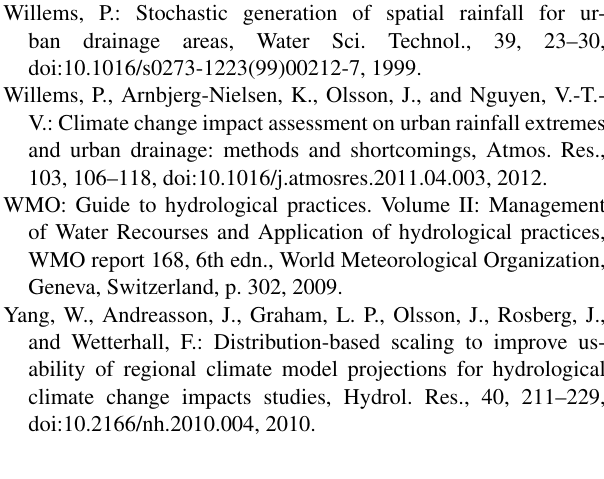
Figueras, T., and Jameleddine, S.: Are stochastic point rainfall models able to preserve extreme flood statistics?, Hydrol.